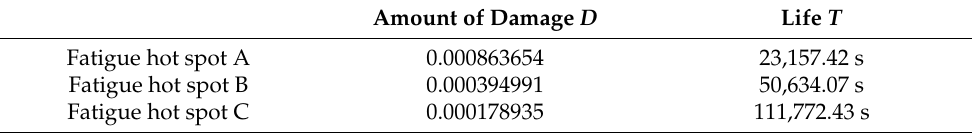
Table 5. Fatigue analysis results of 2-D braided ceramic matrix composite cross stiffened plates.